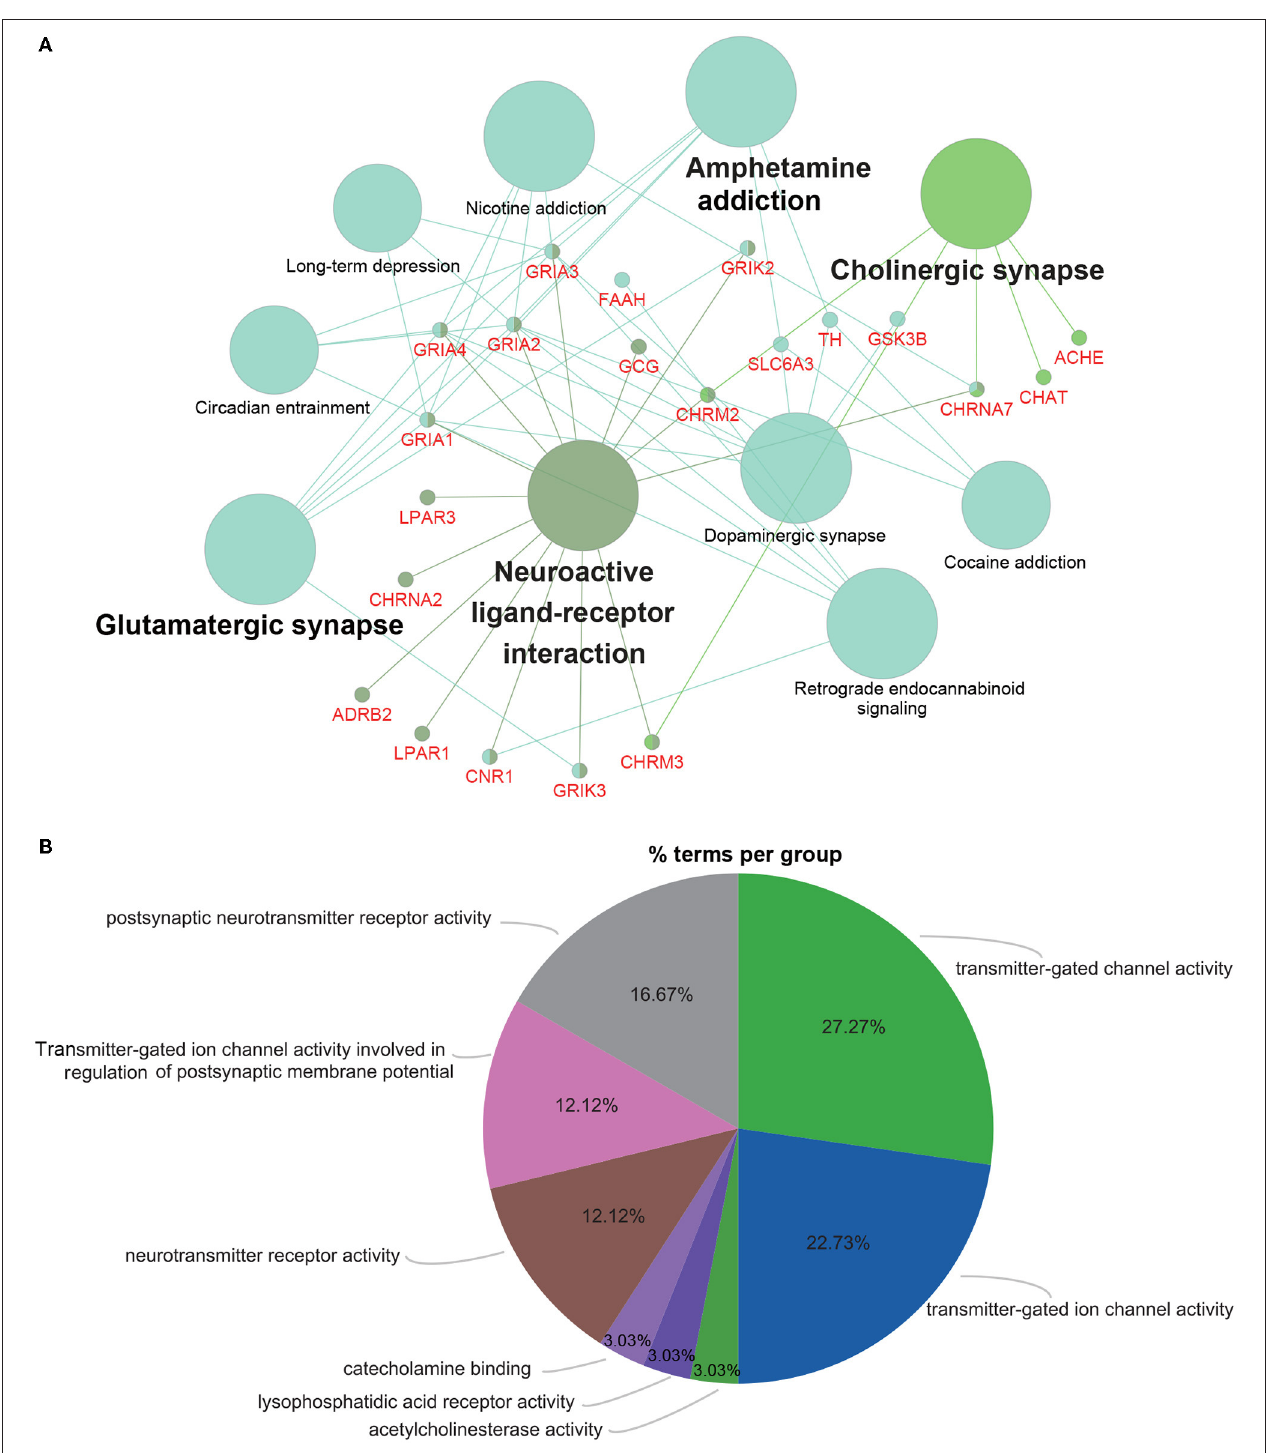
FIGURE 6 | Predicted metabolites and related proteins identified from the database and their associated analysis in the PFC. (A) KEGG pathway enrichment analysis was carried out using ClueGO. All pathways shown with a p < 0.05. (B) Pie chart providing a visualization of the results of GO enrichment analysis of proteins. (For interpretation of the references to color in this figure, the reader is referred to the web version of this article.)